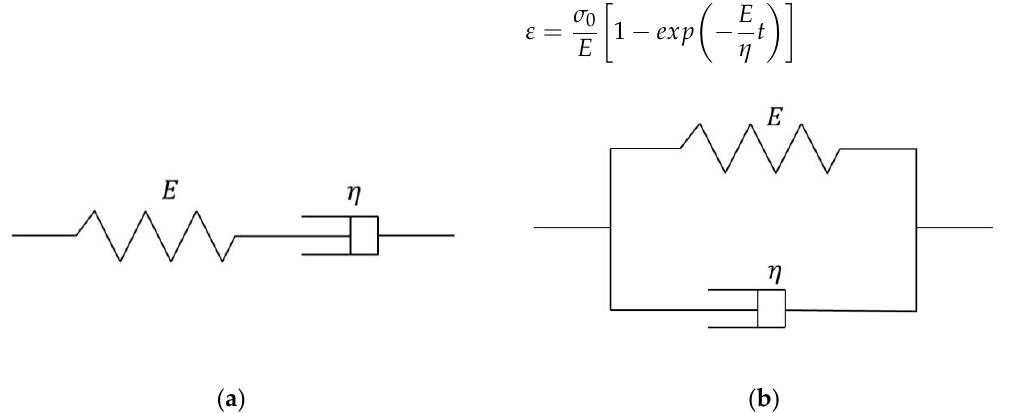
Figure 2. Classic viscoelastic medium models: ( a ) Maxwell model; ( b ) Kelvin – Voigt